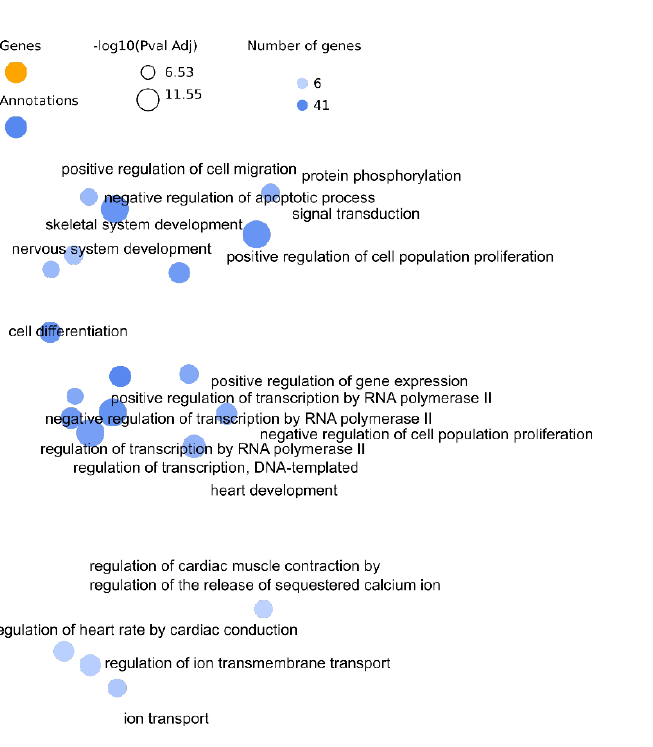
Figure 1. Network plot with genes hidden in the GO BP results of the use case with Wallenius strategy. Three clusters can be observed from top to button, the first related to cell cycle regulation, the second to gene regulation and the last one contains cardiac excitability biological processes.